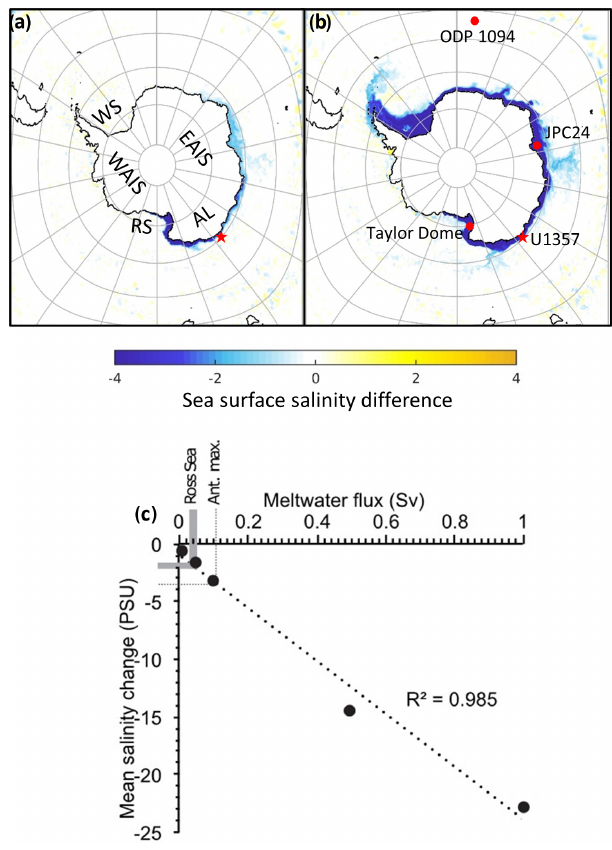
Figure 2. MITgcm simulations of meltwater release from along the edge of the Ross Ice Shelf. The top two images show sea sur- face salinity difference (in practical salinity units) after 3.5 model years resulting from meltwater release volumes of (a) 0.1Sv (2 × 10 13 m 3 total ice volume equivalent) and (b) 0.5Sv (1 × 10 14 m 3 total ice volume equivalent). The red star indicates the position of Site U1357 (this study), and red dots show positions of other core sites mentioned in this study where a mid-Holocene increase in sea ice and/or cooling is recorded: Taylor Dome (Steig et al., 1998; Baggenstos et al., 2018), JPC24 (Denis et al., 2010) and ODP 1094 (Nielsen et al., 2007). AL stands for Adélie Land, RS stands for Ross Sea, WS stands for Weddell Sea, EAIS stands for East Antarctic Ice Sheet, and WAIS stands for West Antarctic Ice Sheet. (c) Scatterplot of simulated meltwater flux (Sv) against mean salinity difference at U1357 core site. The grey band indicates the range of plausible Holocene to deglacial Ross Sea meltwater inputs. The dotted line indicates maximum Antarctic meltwater during the